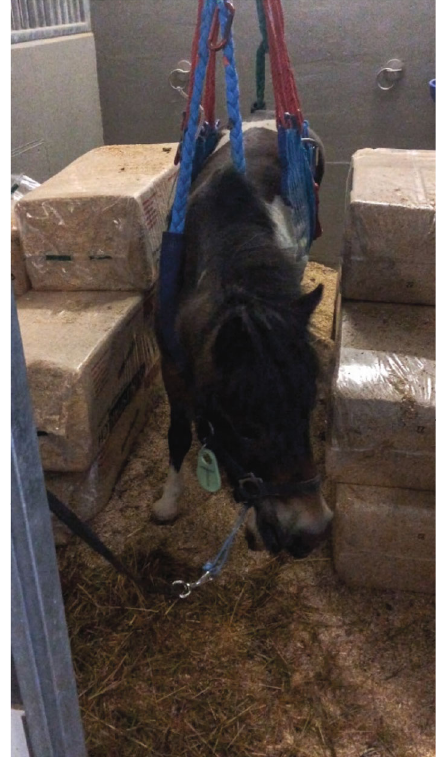
Figure 3: A crosstied Shetland pony mare in a full-body animal rescue and transportation sling (ARTS) after closed reduction of a right coxofemoral